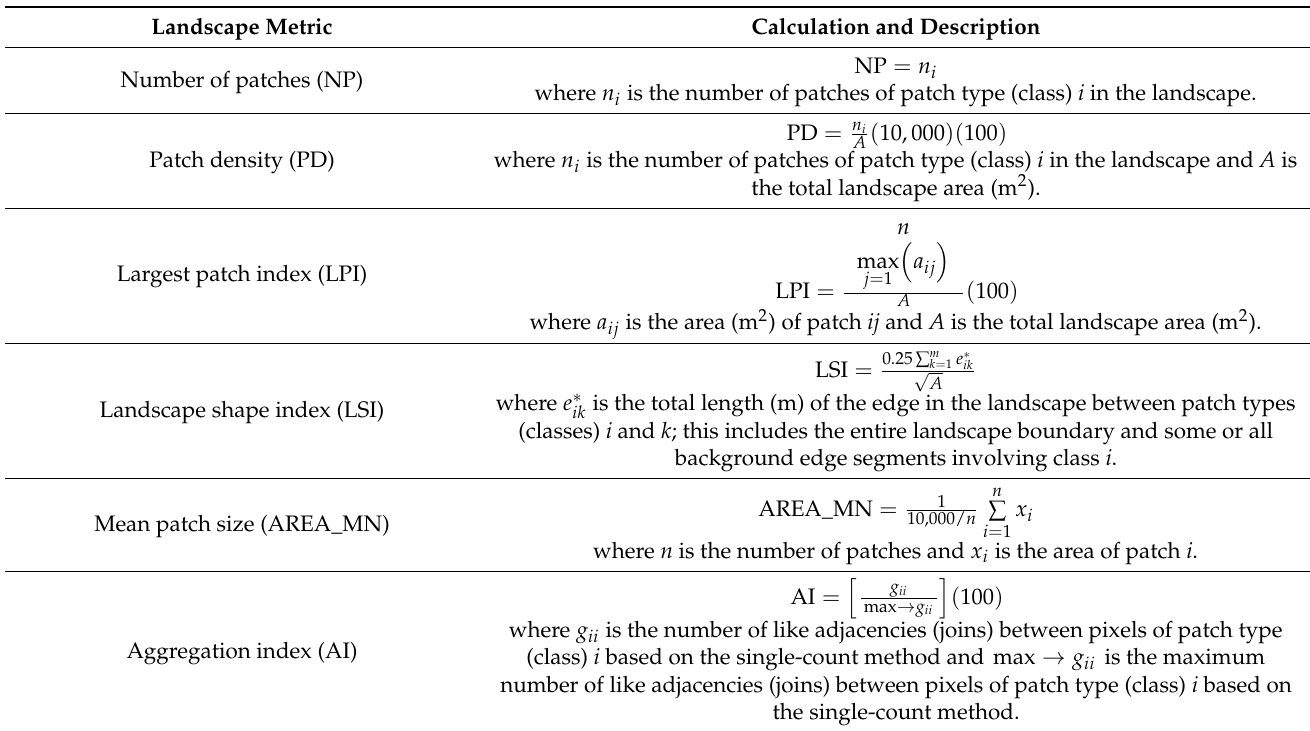
Table 1. Landscape metrics used in this